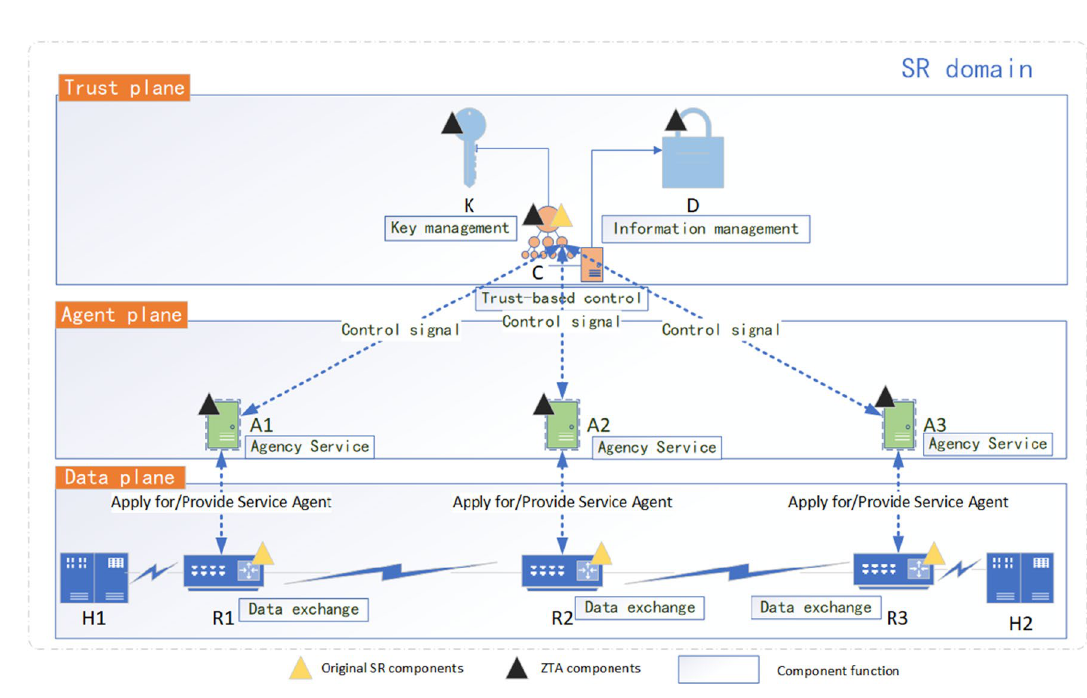
Figure 2. ZbSR security